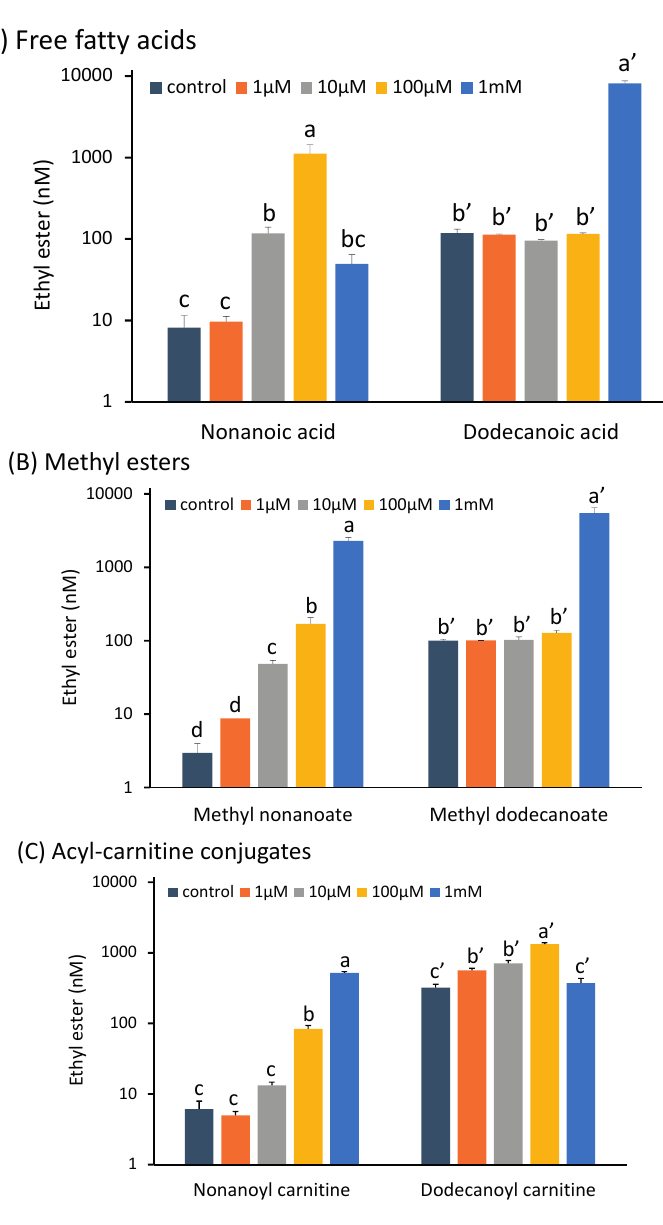
Figure 1. ( A ) Ethyl nonanoate and ethyl dodecanoate concentrations in model wines produced after the addition of increasing amounts of nonanoic acid or decanoic acid to the MGJM; ( B ) Ethyl nonanoate and ethyl dodecanoate concentrations in model wines produced after the addition of increasing amounts of methyl nonanoate or methyl decanoate to the MGJM; ( C ) Ethyl nonanoate and ethyl dodecanoate concentrations in model wines produced after the addition of increasing amounts of nonanoyl carnitine or dodecanoyl carnitine to the MGJM. Histograms represent the mean values (n = 3) and error bars show standard errors. Different letters (e.g., a, b, c, d or a ʹ , b ʹ , c ʹ ) denote significant differences between treatments at p < 0.05 using ANOVA followed by the Games-Howell post hoc test. Note that the y-axis is in log